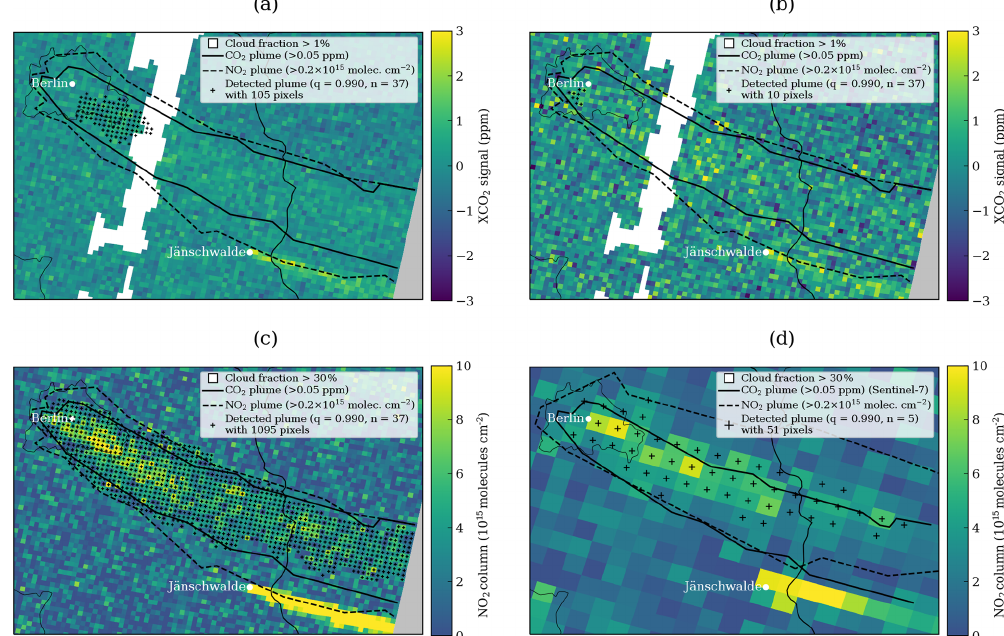
Figure 8. Example of plume detection with CO2M’s CO 2 and NO 2 instrument and Sentinel-5’s NO 2 instrument on 21 April 2015. Significant pixels detected by the algorithm are highlighted as black crosses. The outlines of the true CO 2 and NO 2 plumes based on the X BER tracers are overlaid as solid and dashed lines, respectively. (a) Low-noise CO 2 instrument. (b) High-noise CO 2 instrument. (c) High-noise NO 2 instrument on the CO2M satellite. (d) NO 2 instrument on